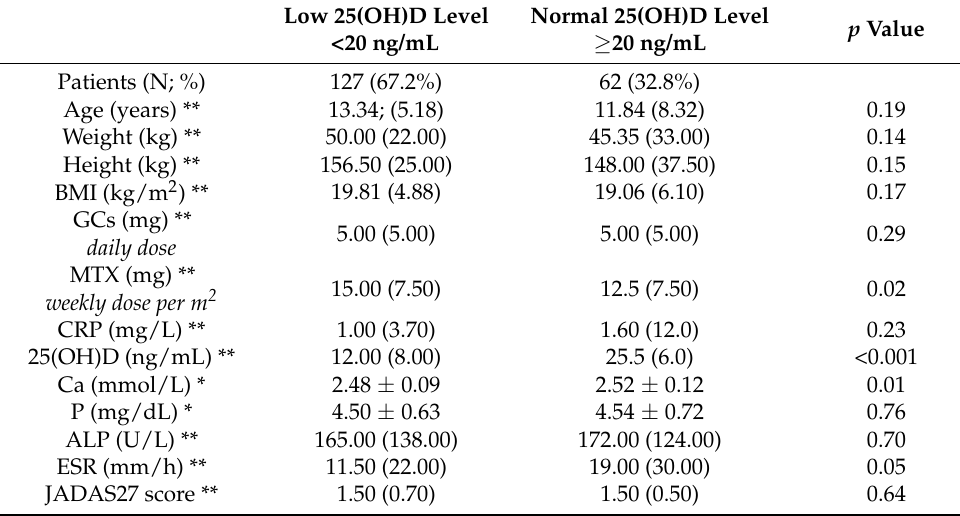
Table 2. Characteristics of the patients with JIA in relation to their serum 25(OH)D concentration below and above 20 ng/mL (* mean ± SD or ** median and IQR are given).